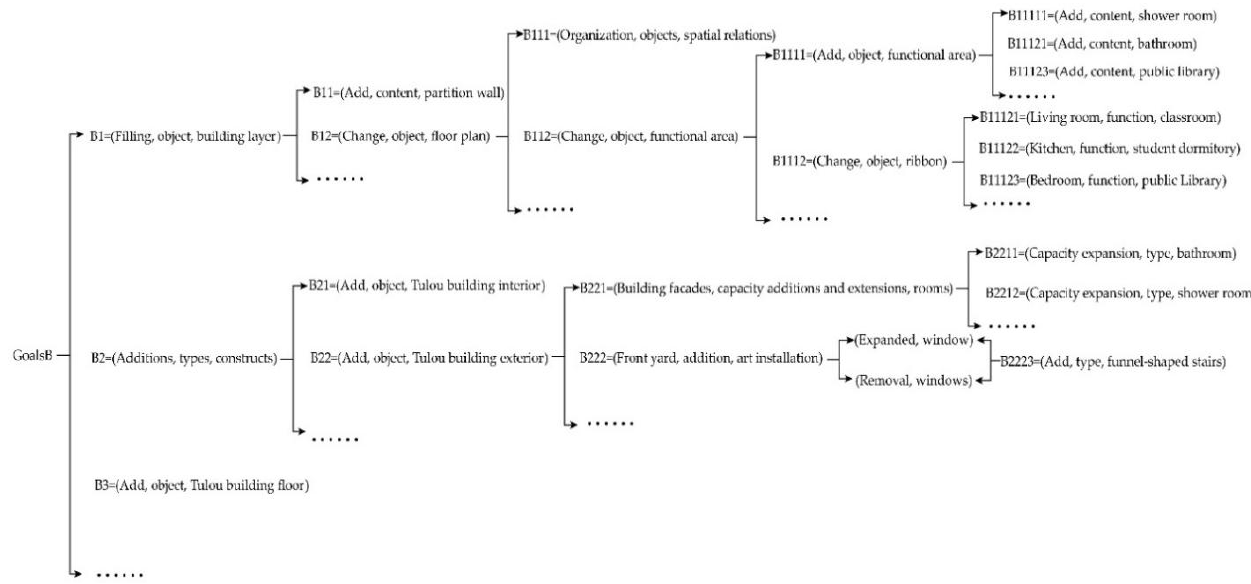
Figure 11. The implied system analysis of the Yude Building.